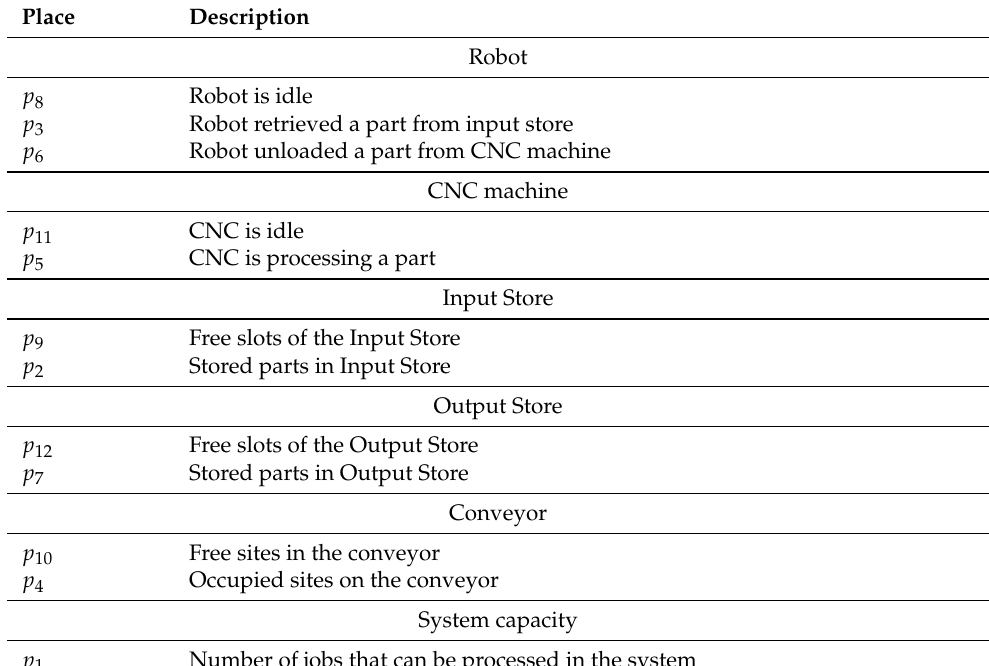
Table 1. Places and their description in the TCPN model of Figure 1b.